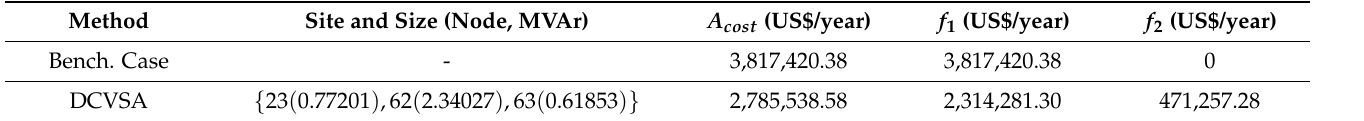
Table 7. Numerical results in the DC version of the IEEE 69-bus